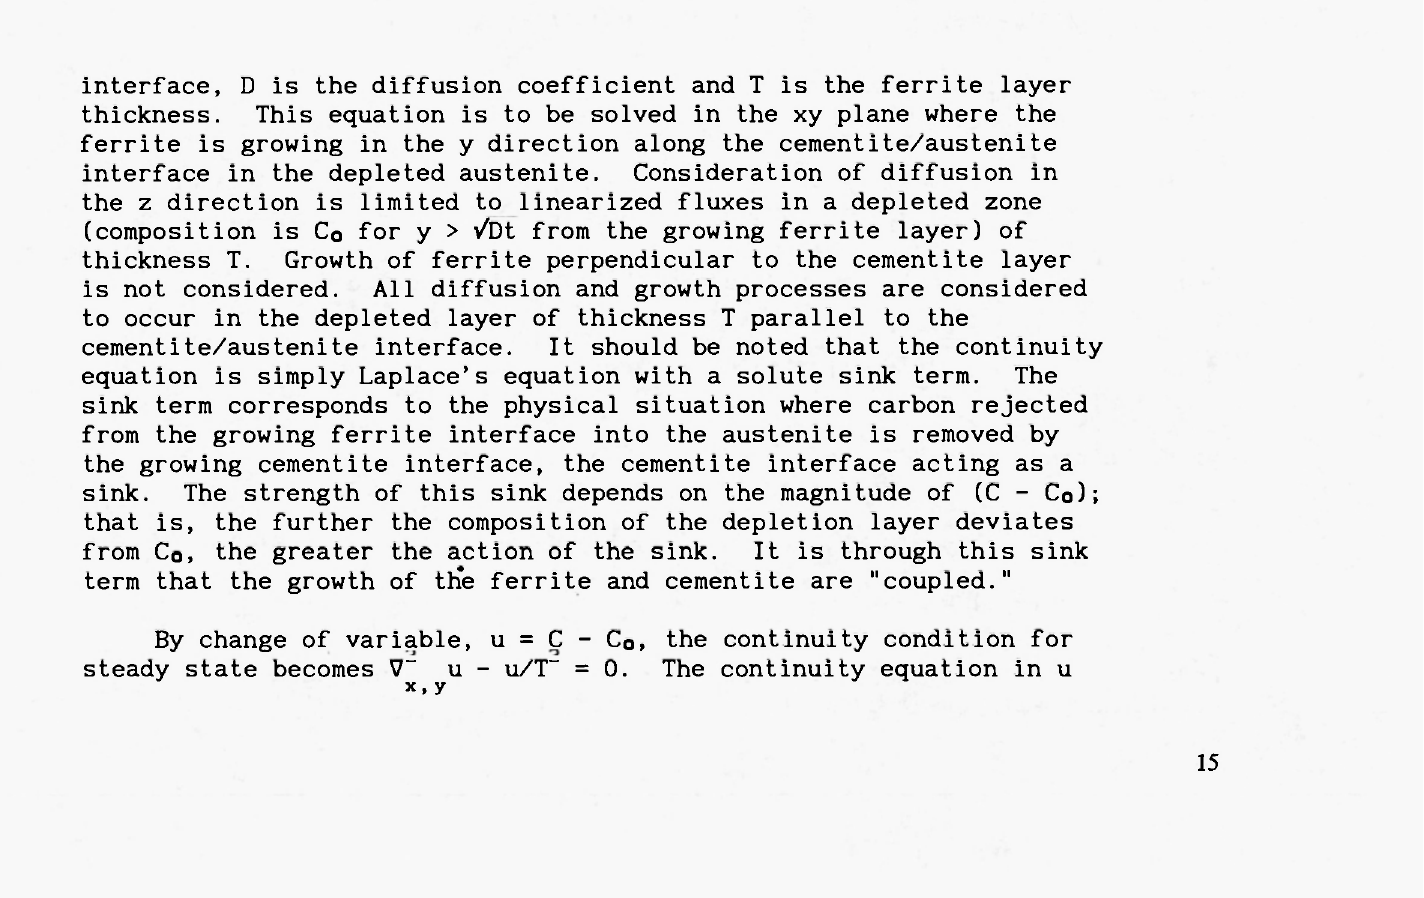
Figure 3. A schematic showing the cross-sectional view (yz plane) and plan view (xy plane) of the geometry being